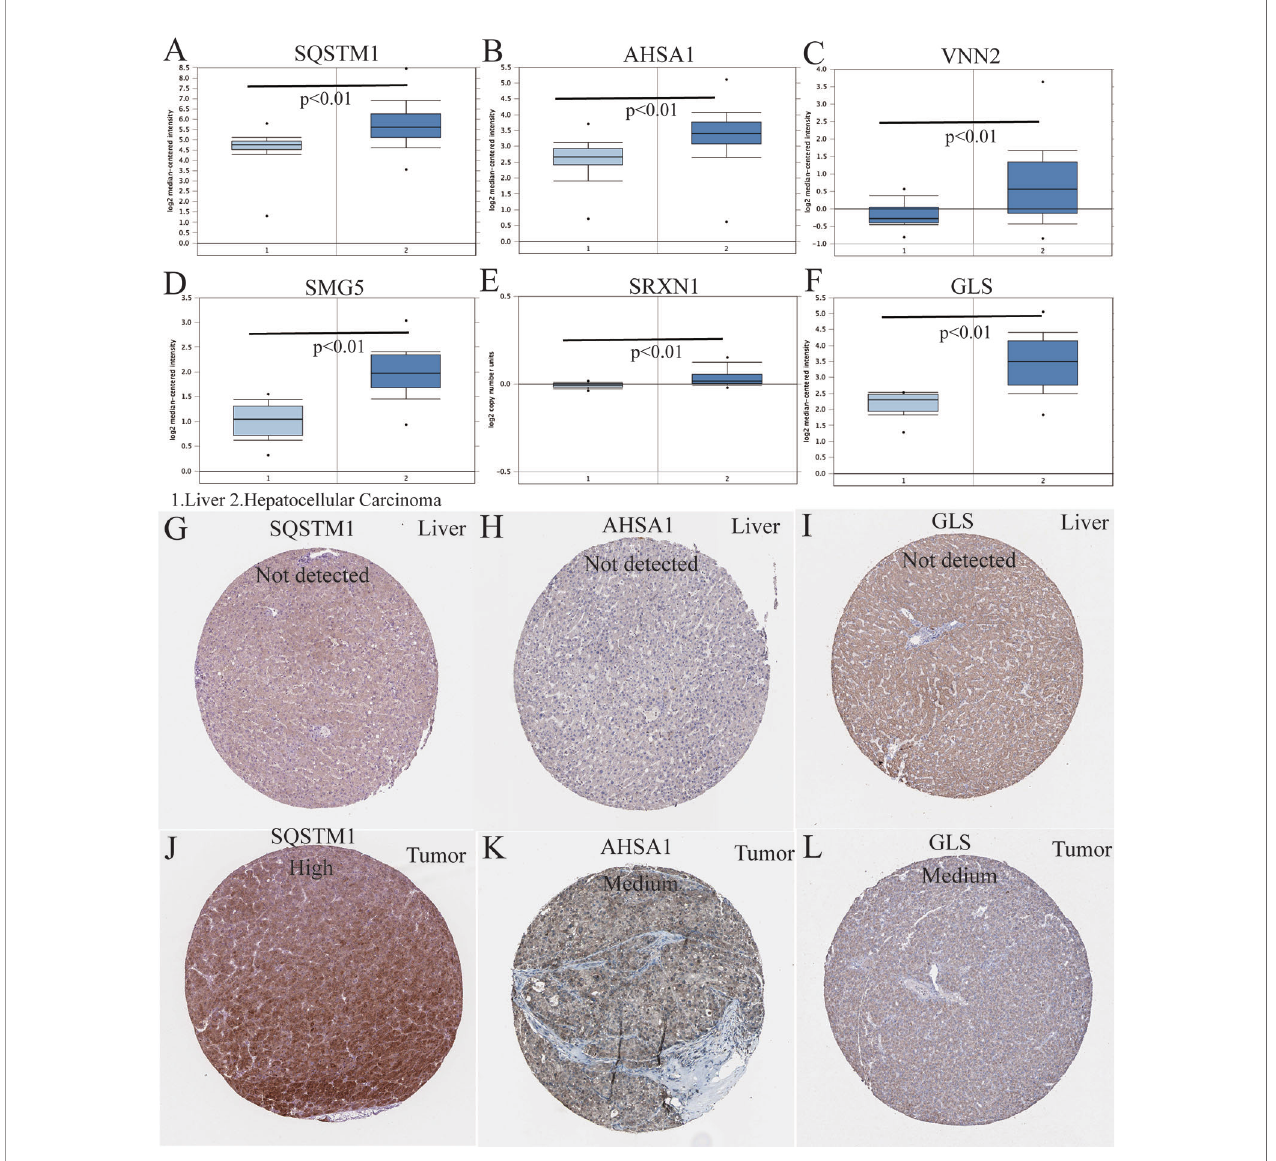
FIGURE 7 | Differences in protein expression induced by six genes were veri fi ed in human tissue samples. (A – F) The mRNA expression levels of the six-gene signature in human cancers (conducted in Oncomine database). (G – L) Human Protein Atlas immunohistochemistry using anti-SQSTM1, anti-AHSA1, and anti-GLS antibodies. Normal liver (G – I) vs. tumor tissues (J – L)